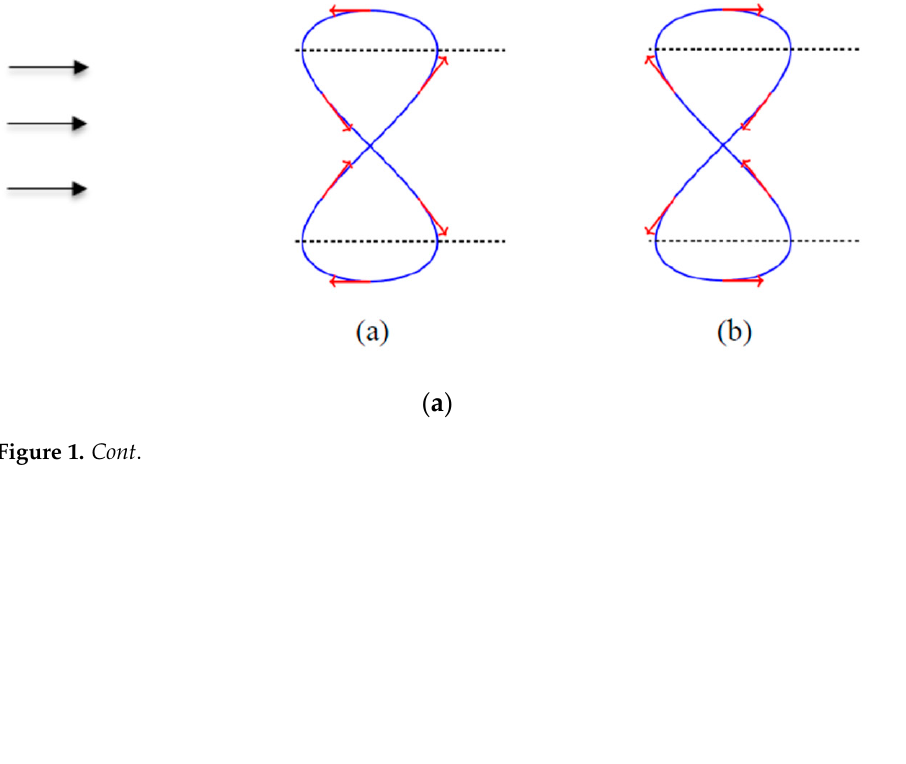
motion. The figure-eight counter-clockwise and clockwise motion corresponds to values of phase shift θ = 0 and θ = π , respectively. A different physical problem is defined for each of the two motions. Considering, for example, the location with maximum distance from the x -axis, the cylinder is moving against or in the direction of the incoming stream, for counter-clockwise or clockwise motion, respectively (Figure 1a). Other values of θ , than 0 and π considered here, correspond to different orbits, and thus different flow dynamics and associated forces. The present study only considers the cases of the two figure-eight trajectories, which are encountered in VIV, and can be used as reference cases, against which others can be compared.